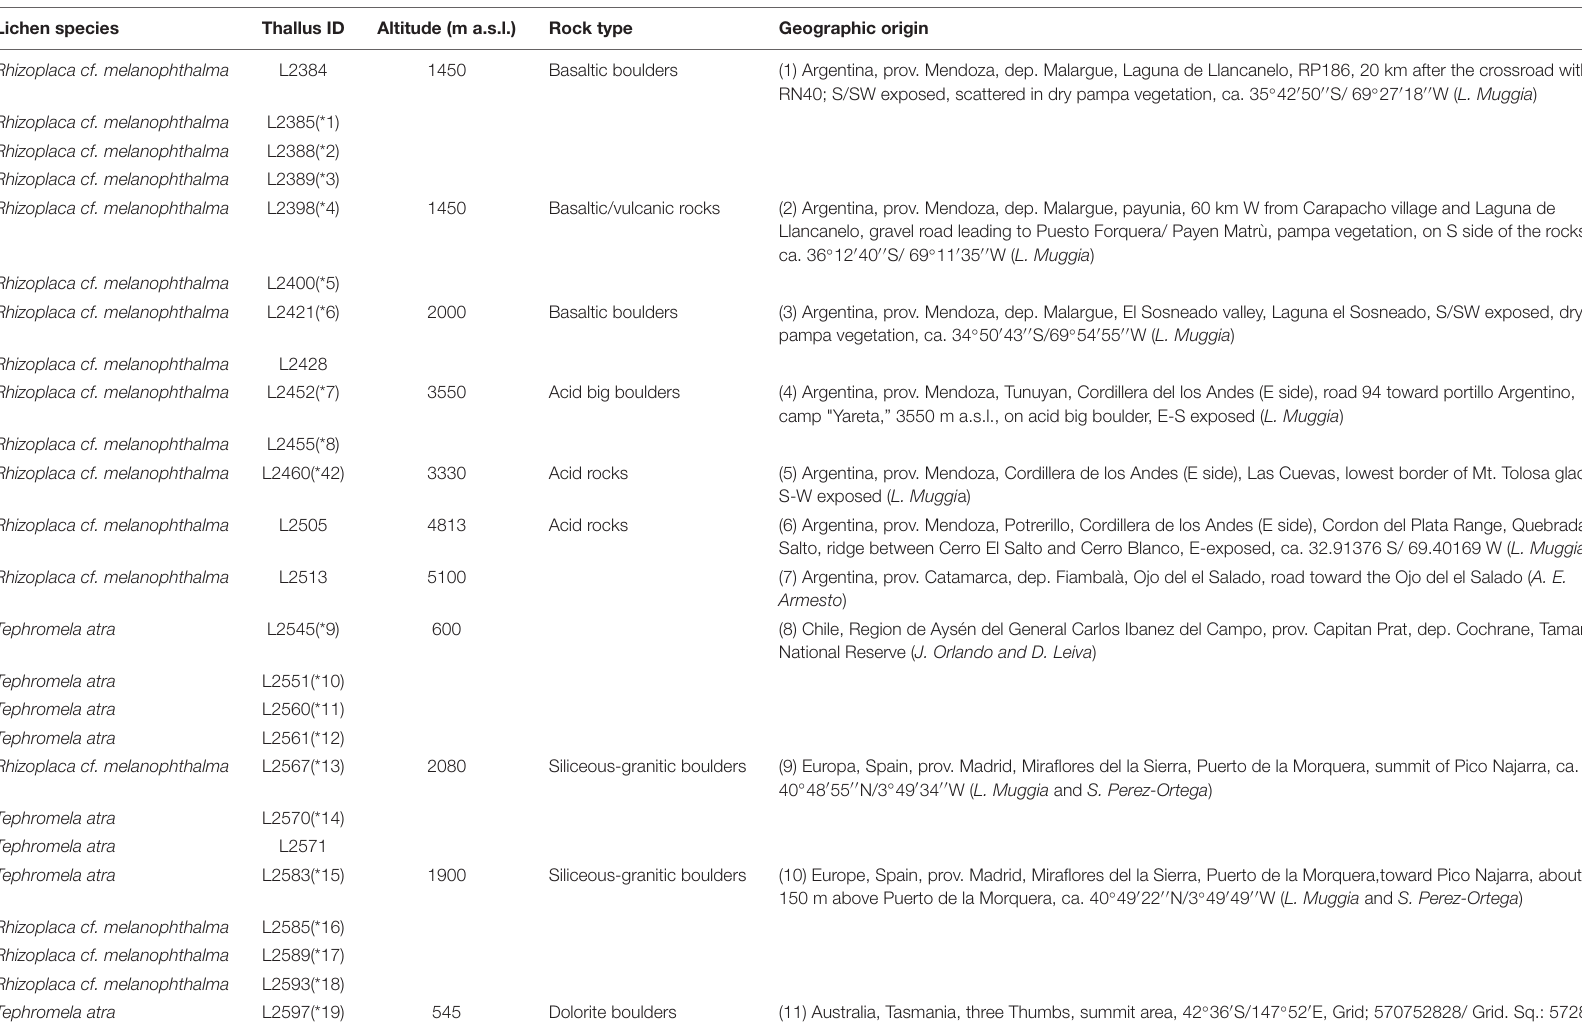
TABLE 1 | Metadata of the collected lichen specimens: species name, sample ID, and geographic origin, including altitude and type of substrate, are reported. Lichen species Thallus